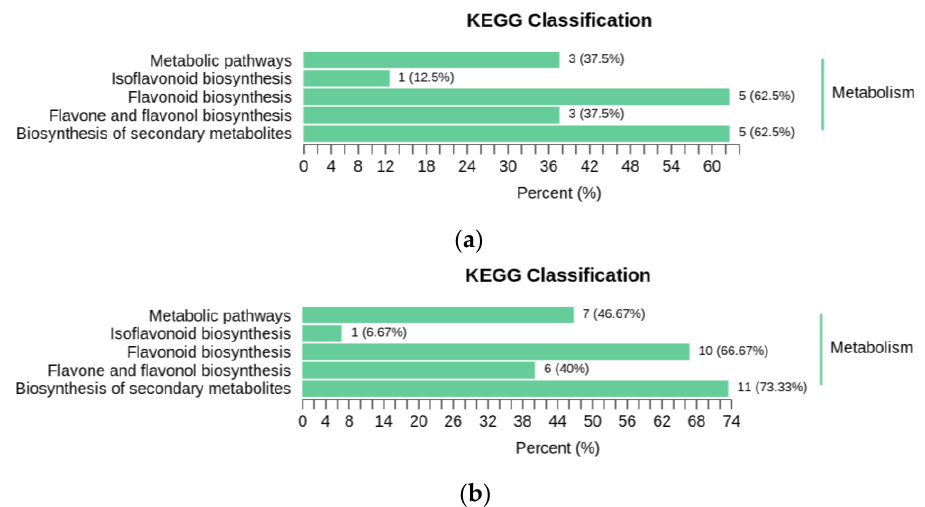
Figure 8. KEGG enrichment analysis of the differential metabolites in the comparisons of ( a ) GZ2 vs. CK and ( b ) GZ4 vs. CK.